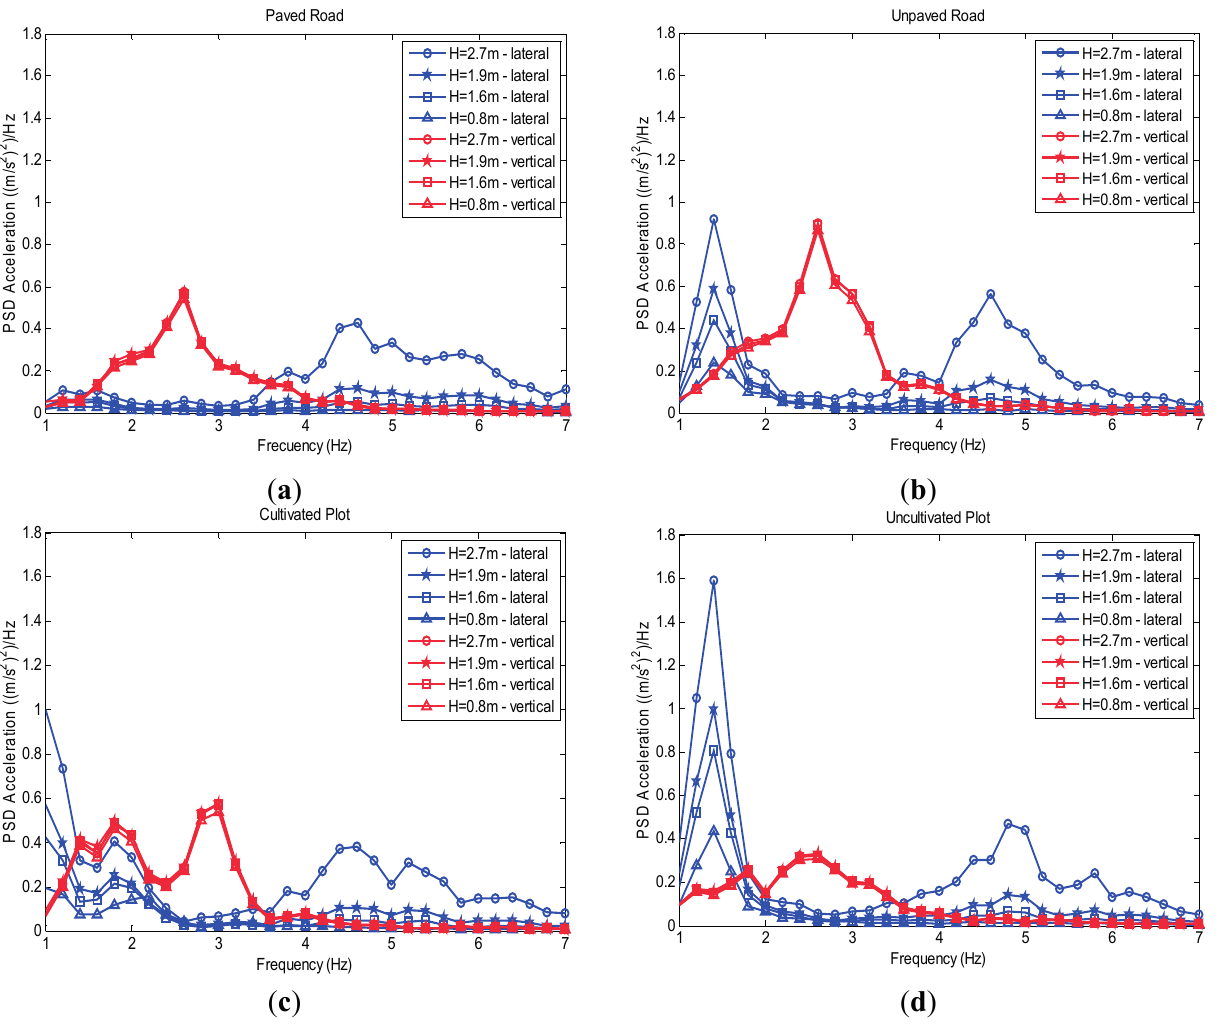
Figure 7. Power spectrum density plots of measurements acquired with accelerometers placed on the rear axle of the tractor at heights of 0.8, 1.6, 1.9, and 2.7 m above the ground. Graphs are shown for vertical (red) and lateral (blue) vibrations on paths along the paved road ( a ), the unpaved road ( b ); the cultivated plot ( c ); and the uncultivated plot ( d ).